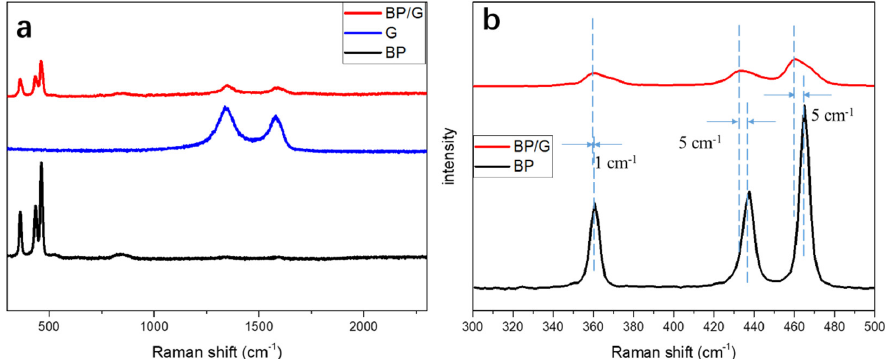
Figure 3. ( a ) Raman spectra of BP, G, BP/G composite material; and ( b ) the enlarged Raman spectra of BP and BP/G.